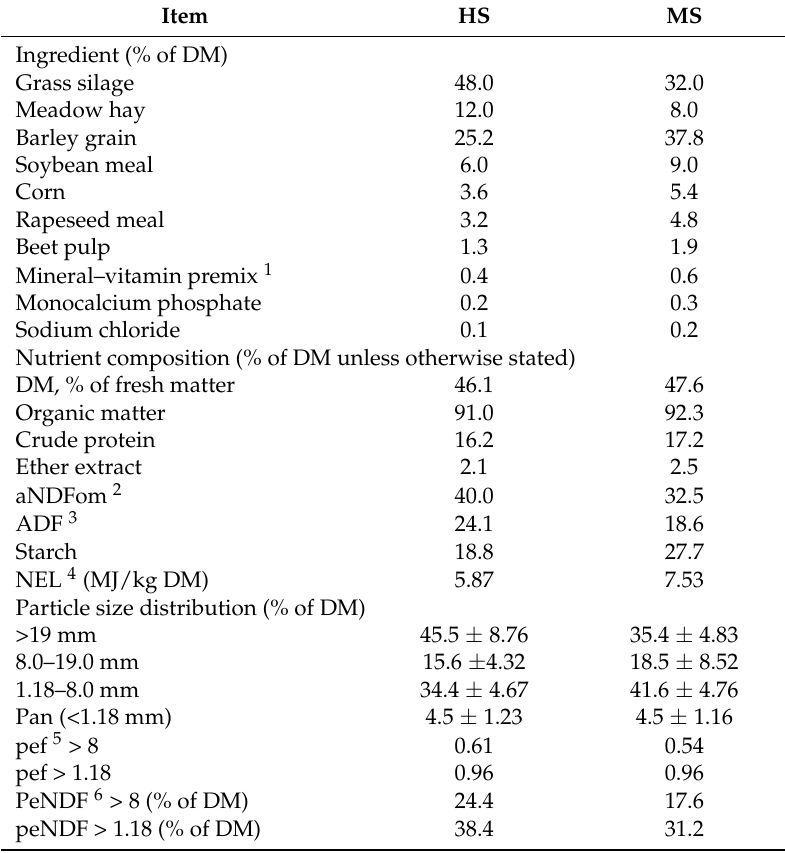
Table 1. Ingredients, analysed nutrient composition, and particle size distribution in a 40% concentrate diet, high in physical structure (24.4% peNDF > 8 mm DM basis; HS) or a 60% concentrate diet with moderate physical structure content (17.6% peNDF > 8 mm;